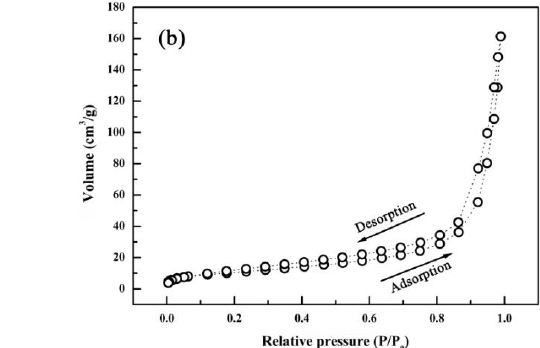
Figure 6. BET curves of θ-Al 2 O 3 whiskers fabricated by the hydrothermal method with the different molar ratio of Al 3+ :CO(NH 2 ) 2 of ( a ) 1:5 and ( b ) 1:6 followed by annealing at 1000 °C.